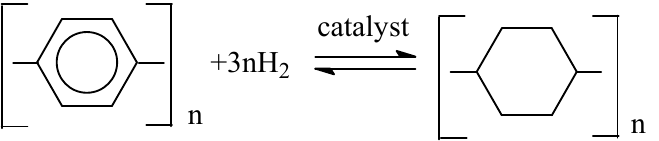
Figure 2. Hydrogenation–dehydrogenation of cyclic compounds for hydrogen storage.